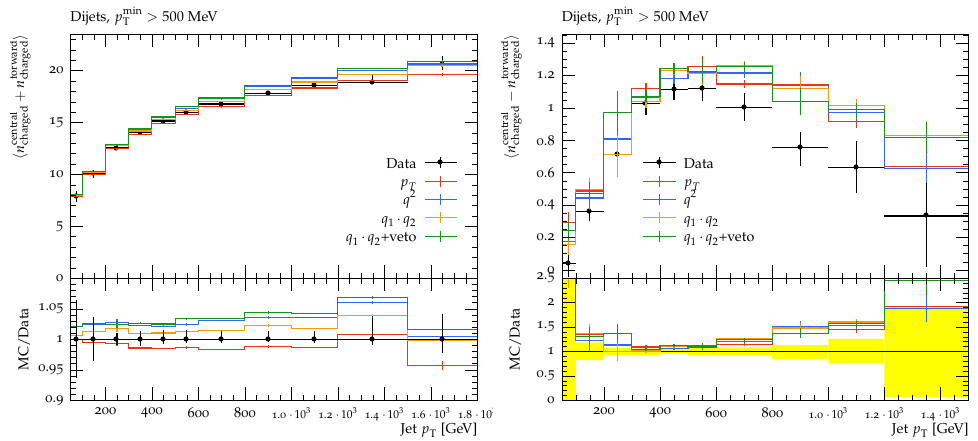
Figure 10 . The average number of charged particles in jets (left) and the di(cid:11)erence between the average number of particles in central and forward jets (right) as a function of the jet transverse momentum compared with data from the ATLAS experiment